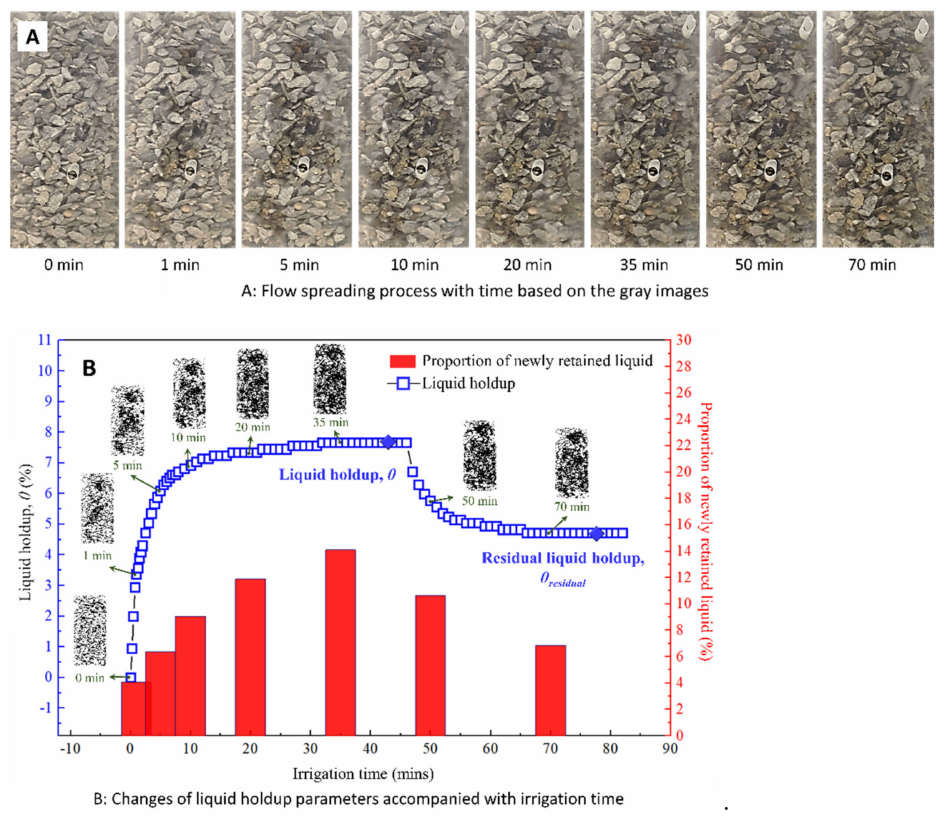
Figure 2. Liquid spreading process with irrigation time ( A ), quantification of liquid holdup and cross-section porosity in unsaturated ore packed bed ( B